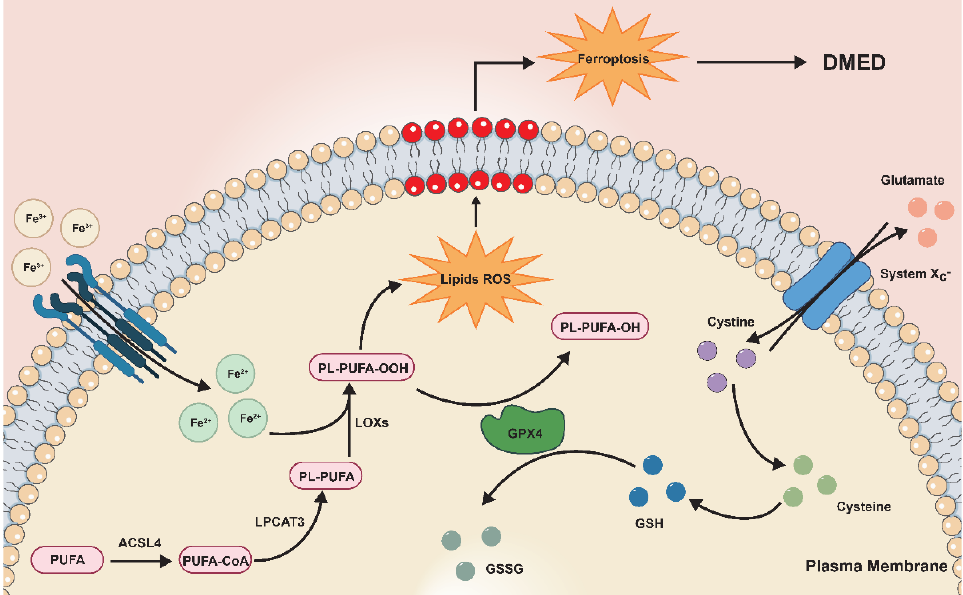
Figure 7. Proposed mechanism of ferroptosis in DMED. More polyunsaturated fatty acids (PUFAs) are catalyzed into lipid peroxides with the help of the upregulated ACSL4-LPCAT3-LOX pathway in DMED. The cystine-glutamate anti-transporter (system Xc-) transports cystine into the cell, which participates in the synthesis of glutathione. Less glutathione reduces lipid peroxides under the catalysis of decreased GPX4 expression in DMED. The above molecular changes were alleviated after GPX4-LV injection. Subsequently, the level of ferroptosis is reactively improved. The end result of these processes is the amelioration of erectile function in DMED.